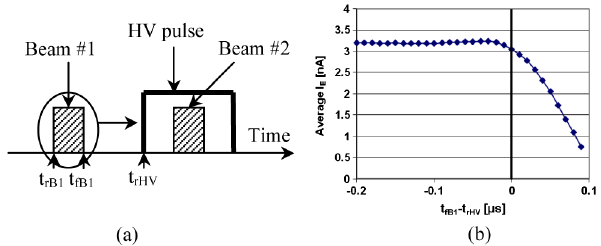
FIG. 5. (a) Schematic pulse-structure diagram of the test, ¼ 0 : 42 (cid:1) s , T ¼ 1 (cid:1) s , V ¼ 1 , 1.5, 2 kV; the beam T B1 HV HV pulse was swept across the HV pulse in steps of 10 ns. (b) Average I E at each step. The first vertical line: t fB1 ¼ t rHV ; second vertical line: t rB1 ¼ t rHV ; third vertical line: t fB1 ¼ t fHV ; fourth vertical line: t rB1 ¼ t fHV .